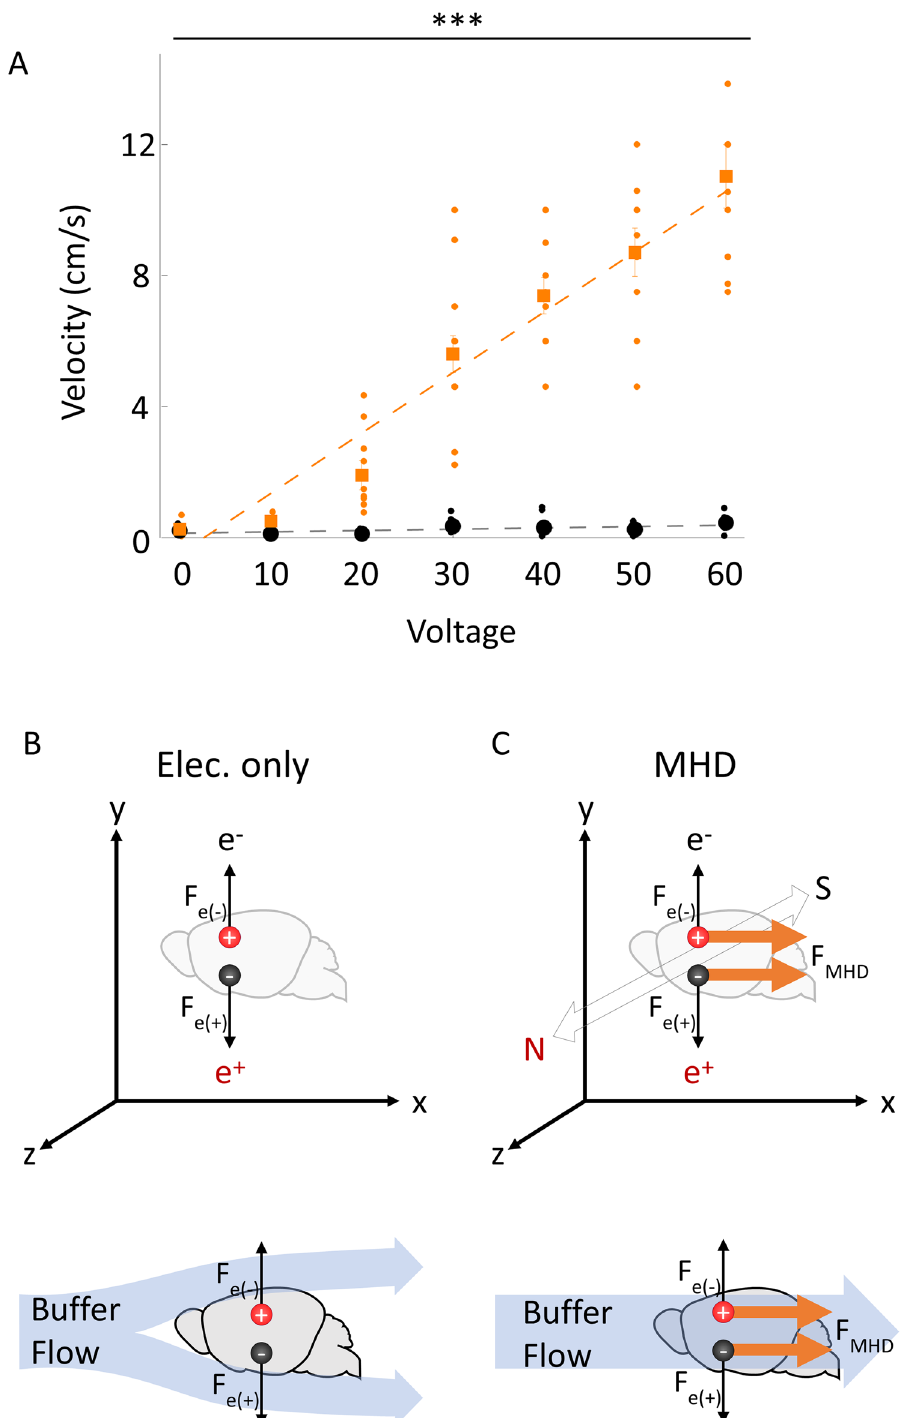
Figure 1. Comparison of voltage effects on buffer velocity between MHD and electrical forces. ( A ) Velocity of sodium alginate spheres through the MHD-accelerated clearing device with (orange) and without a magnetic field (black; N = 7; error bars: standard error of the mean). MHD-acceleration increases produced higher velocities than electric-only across all voltages ( p < 0.0001 (***); 2-way ANOVA (F{2,6} = 38.51; pairwise comparisons: 10 V: p = 0.002, 20 V: p = 0.0005, 30 V: p < 0.0001, 40 V: p < 0.0001, 50 V: p < 0.0001, 60 V: p < 0.0001). The MHD and electric datasets are fit to linear models y = 0.18 x − 0.48 (orange) and y = 0.004 x + 0.15 (grey) respectively. Illustrations of the effects of an electric field ( B ) or conjugated electric and magnetic field ( C ) on positively charged (red) or negatively charged (black) particles. The force induced on each particle by the electric field alone (black arrow) and MHD force (orange arrow) are shown as vectors. The cartoons below show the buffer flow induced by an external pump in conjunction with electrical force ( B ) or by MHD force alone ( C ). The flow of the buffer is shown as blue arrows where the MHD force (orange vector) continues to push buffer through the tissue, while the external pump produces flow around the